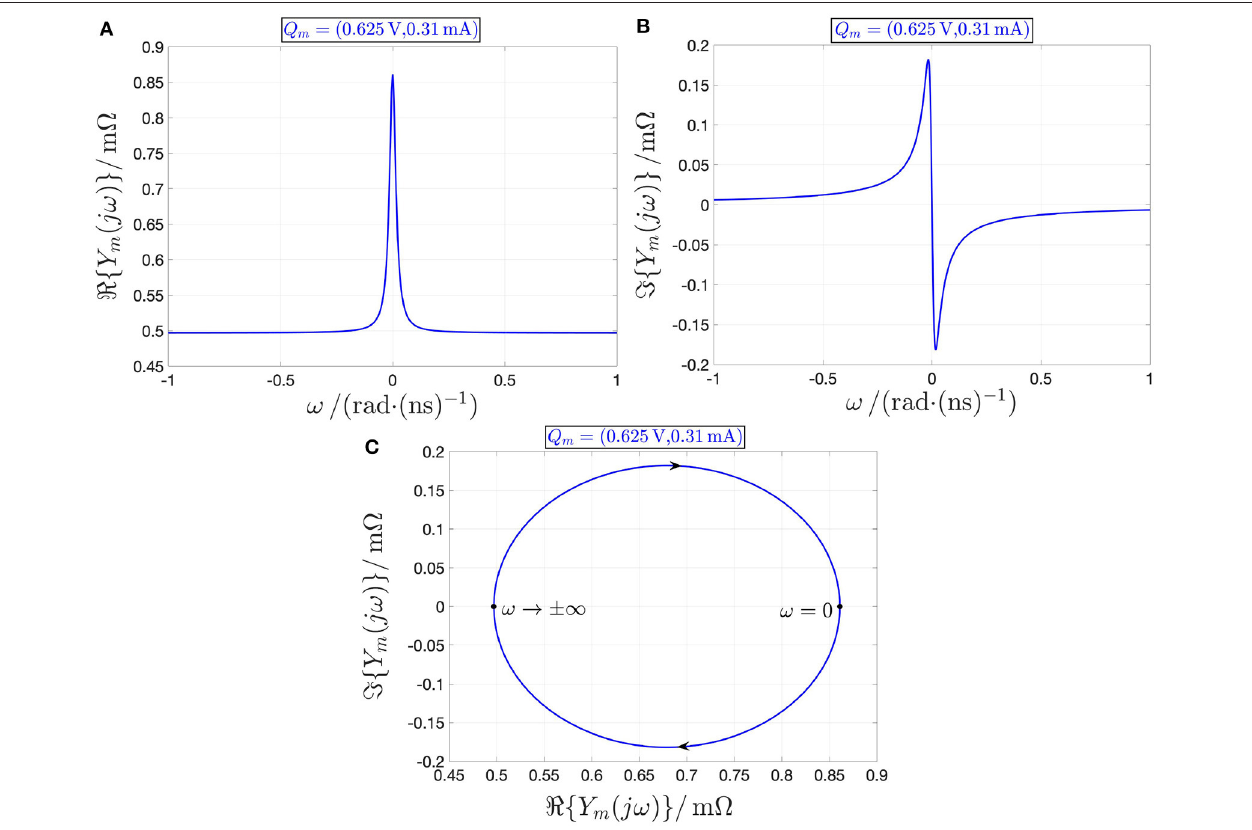
FIGURE 13 | Loci of the real (A) and imaginary (B) parts of the local impedance Y m ( j ω ) of the memristor vs. the angular frequency ω at the operating point Q m Y m ( j ω ) Y m ( j ω ) ( V m , I m ) (0.625V,0.31mA). (C) Locus of vs. , as computed from (A,B) , with arrows showing how the trajectory point evolves along the = = ℑ{ } ℜ{ } Nyquist plot as ω increases from to . The real part of the device local admittance is positive for all angular frequencies. Under voltage control, the threshold −∞ +∞ switching device is locally passive at the PDR operating point Q m under focus.